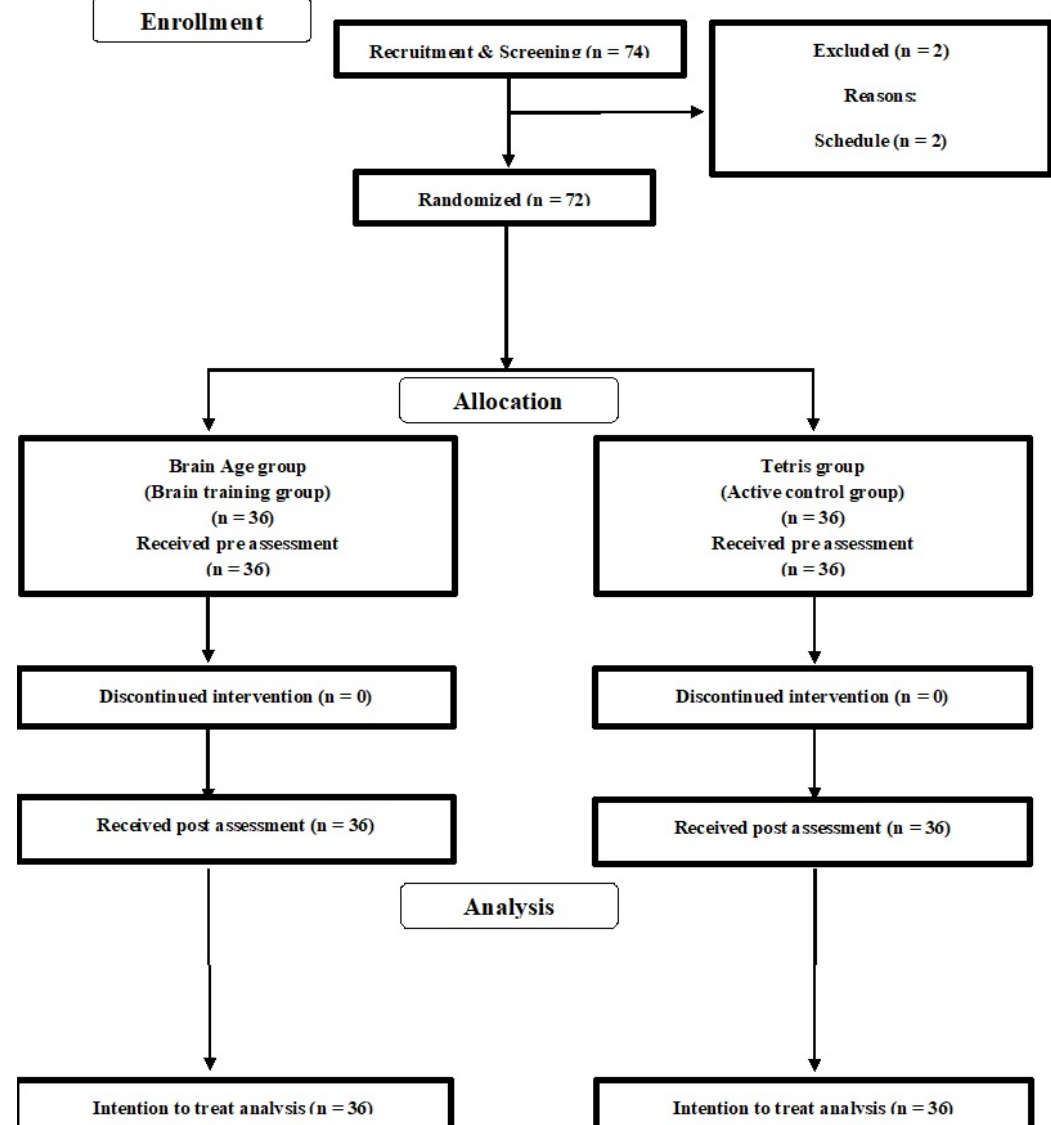
Figure 1. The Consolidated Standards of Reporting Trials (CONSORT) diagram.